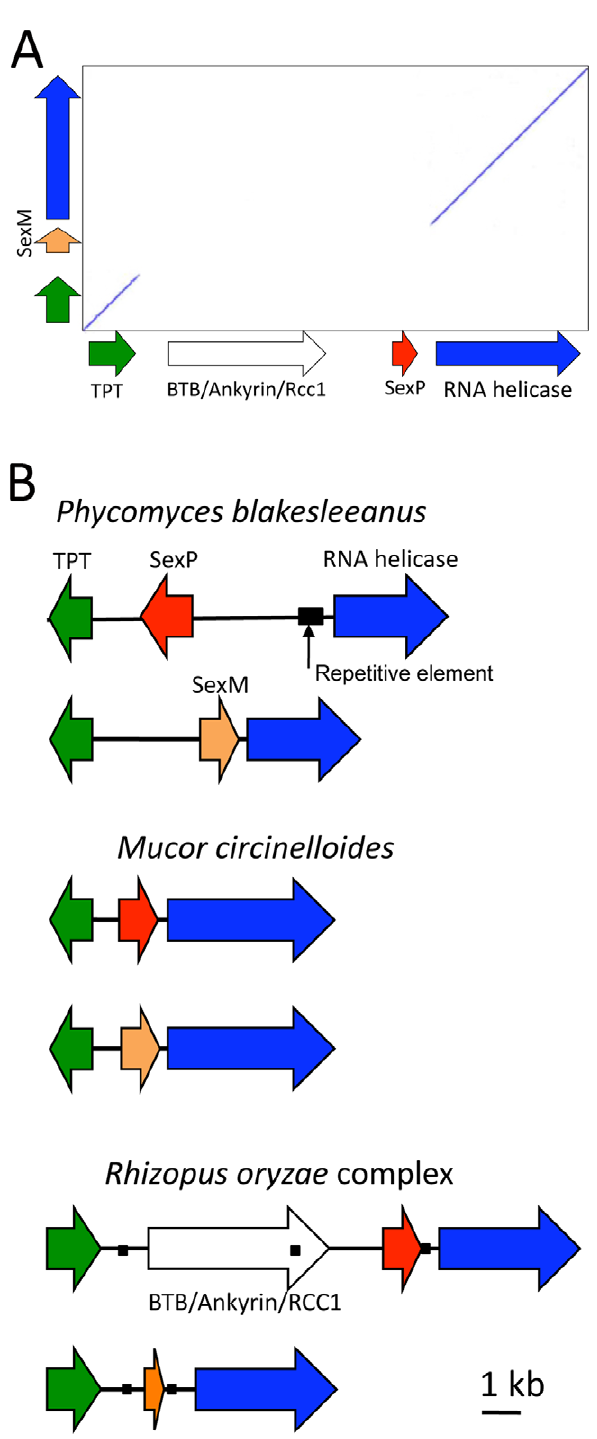
Figure 2. Comparison of sex locus structure in the Mucorales (Mucoromycotina, Zygomycota). (A) Dot plot showing the diver- gent DNA sequence of sexP and sexM genes in Rhizopus oryzae , whereas the TPT and RNA helicase genes are highly conserved. The orientations of sexP and sexM genes are the same in R. oryzae . (B) sex locus structures of P. blakesleeanus and M. circinelloides [46] are compared with R. oryzae (this study). Relative to R. oryzae , the TPT gene in M. circinelloides and both the TPT gene and sexP in P. blakesleeanus have an inverted orientation. The ( + ) allele of R. oryzae contains an additional gene between the TPT gene and sexP that is not found in the other two species or in the ( 2 ) allele of R. oryzae . Black boxes show repetitive